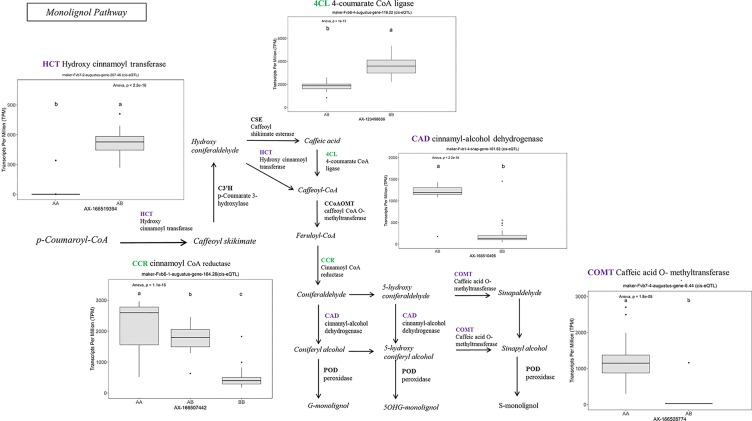
eQTL controlling monolignol pathway gene expression. Marker effect sizes are indicated by box plots stratified by allelic state (AA, AB, or BB) and shown with ANOVA p-values. eQTL genes based on the ‘Camarosa’ genome are indicated as either possessing the highest sequence identity to the published sequence (purple) or not (green). Letters represent statistically separable means via Tukey’s HSD post hoc test (p < 0.05).